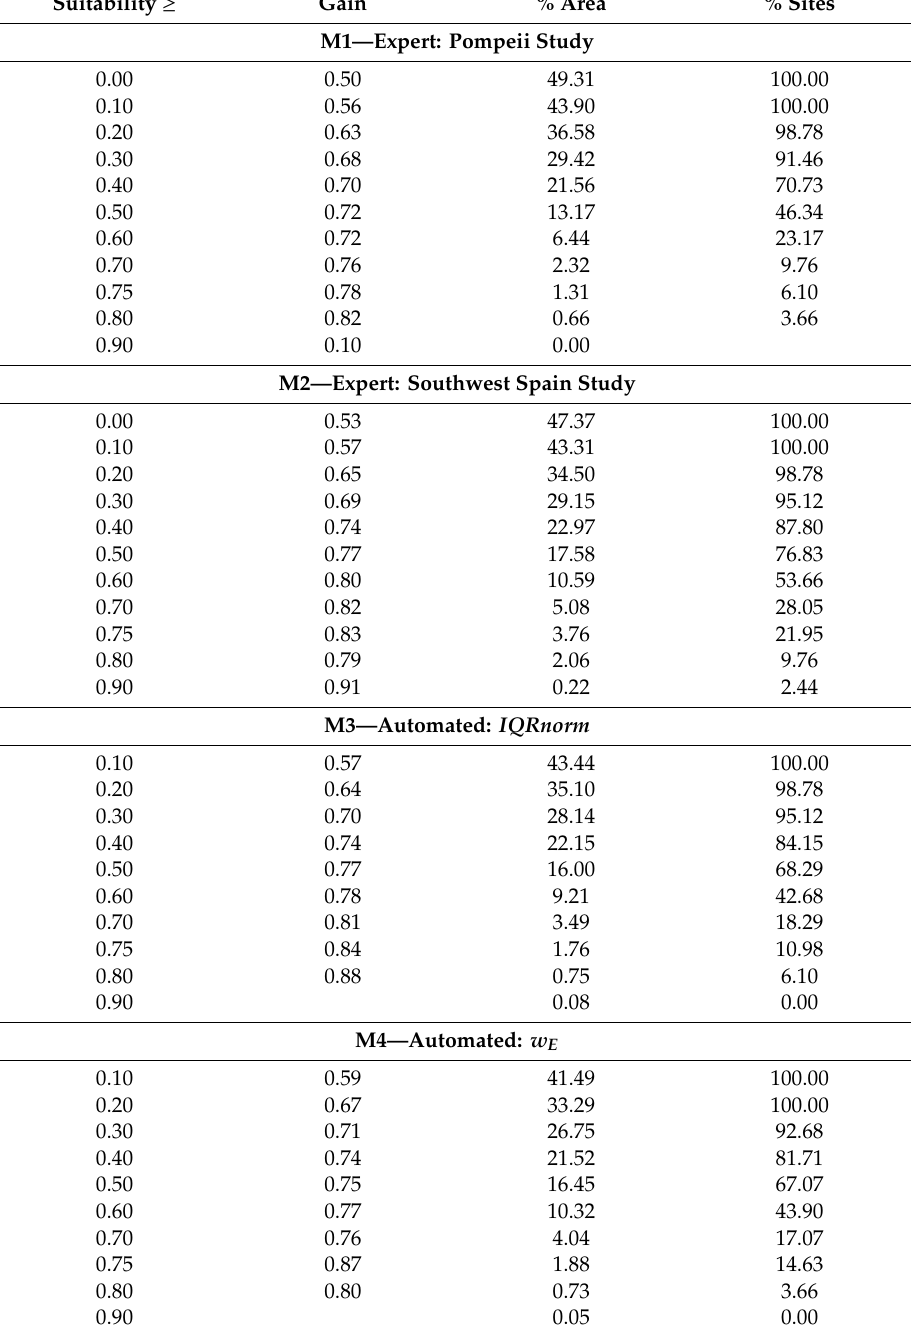
Table A3. Variable importance ranking of the predictive